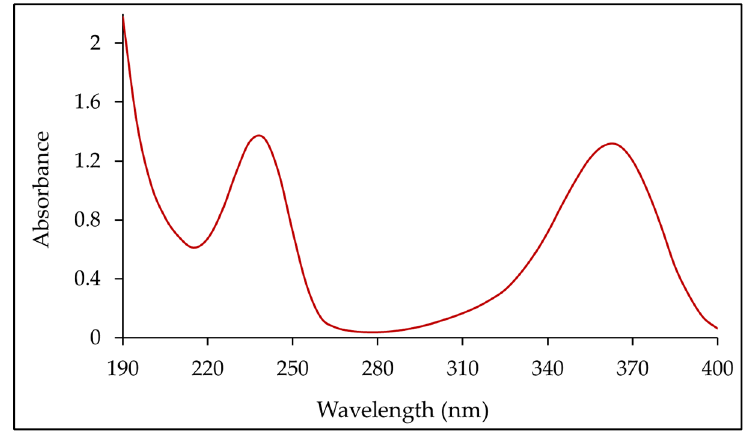
Figure 3. UV-Vis spectrum of favipiravir.